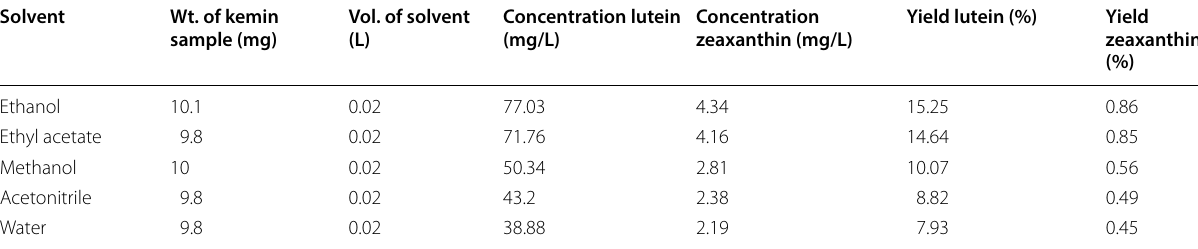
Table 1 Test to determine suitable solvent for lutein and zeaxanthin extraction and purification Solvent Wt. of kemin sample (mg) Lutein and zeaxanthin were most soluble in ethanol